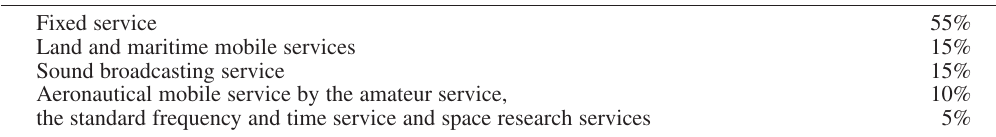
Table 1.I. Approximate fractional usage by the different radio services of the HF-bands. Fixed